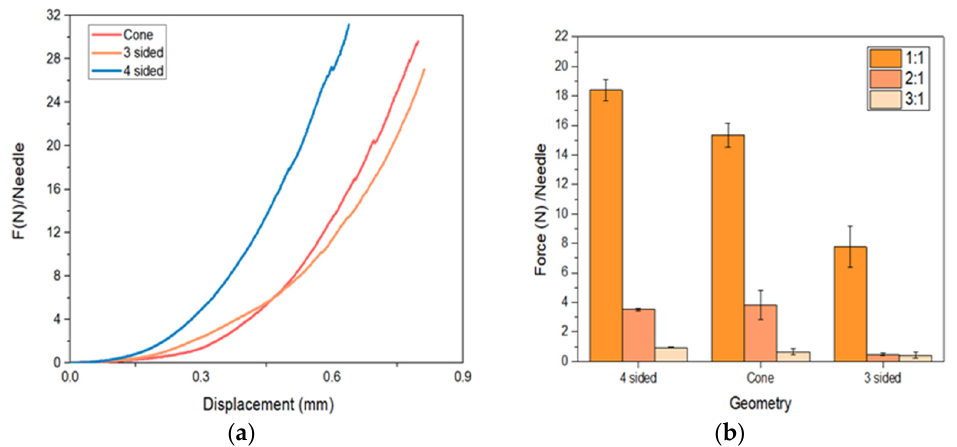
Figure 9. Obtained values on MN axial force measurements considering ( a ) 1:1 ratio; ( b ) different ratios and geometries.